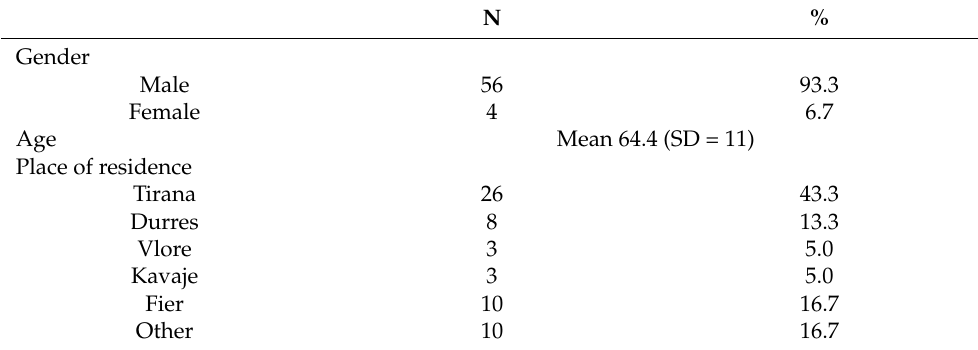
Table 1. Demographic characteristics of patients.